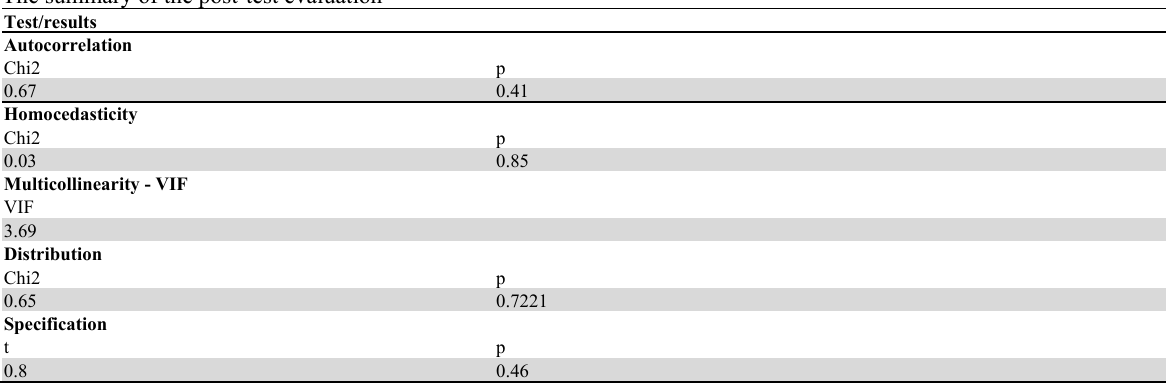
The summary of the post-test